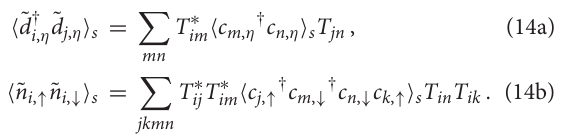
eigenstate s and are given